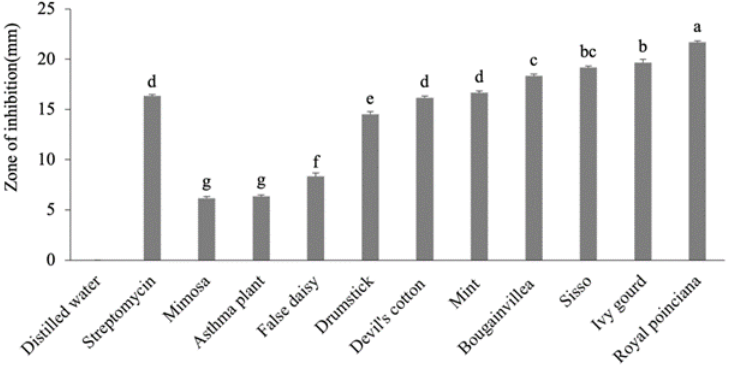
Figure 1 Antibacterial effect of 25% aqueous extracts of medicinal plants. e letters represent the significant effects of plants on each other. e whiskers above the bars represent standard error ( SE